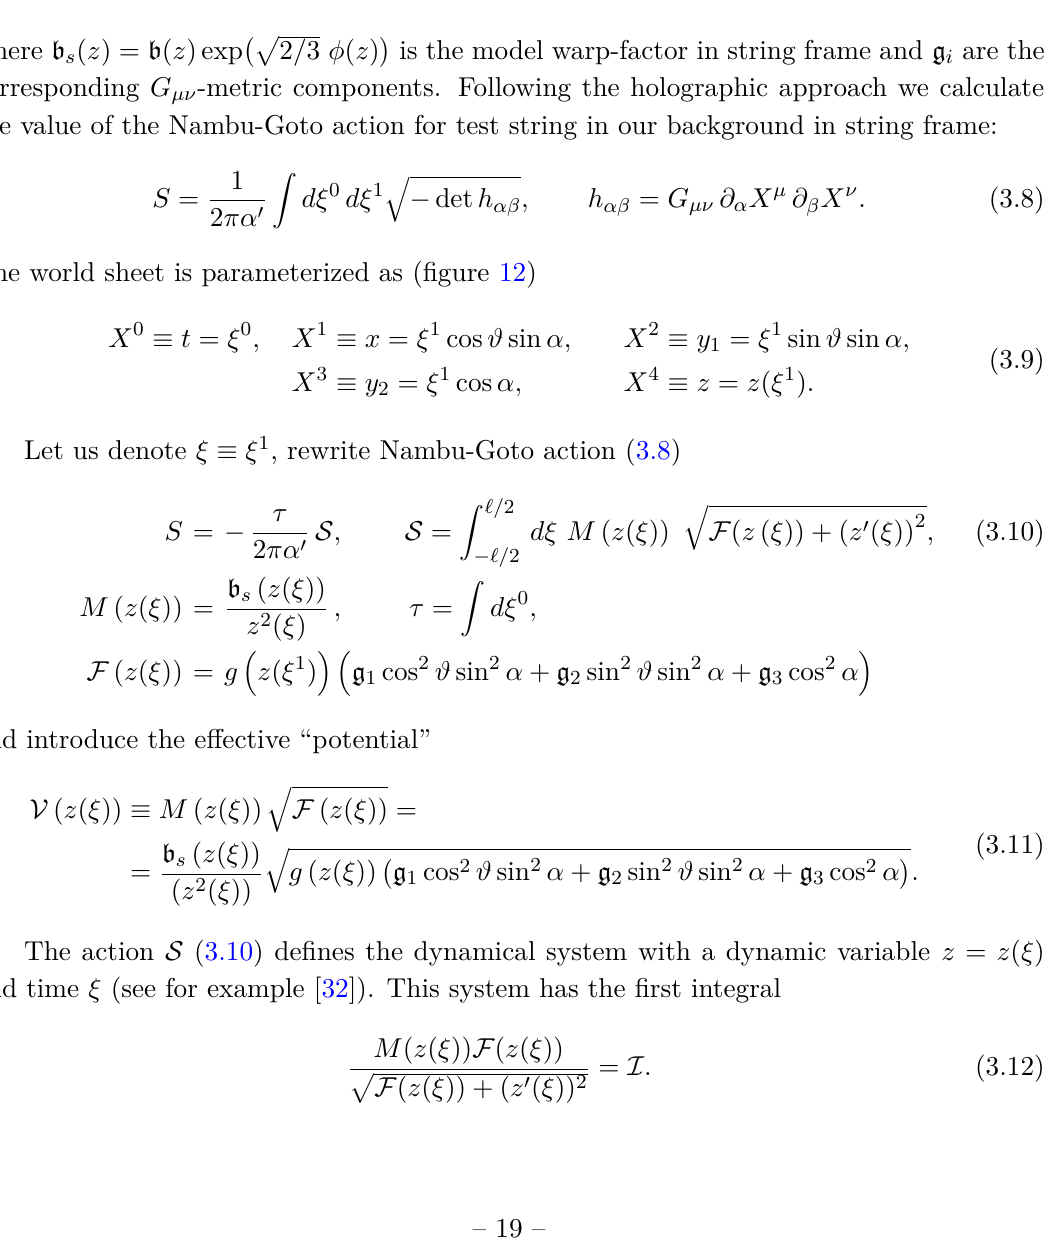
Figure 12 . World sheet parametrization for the Wilson loop orientation vector ~n